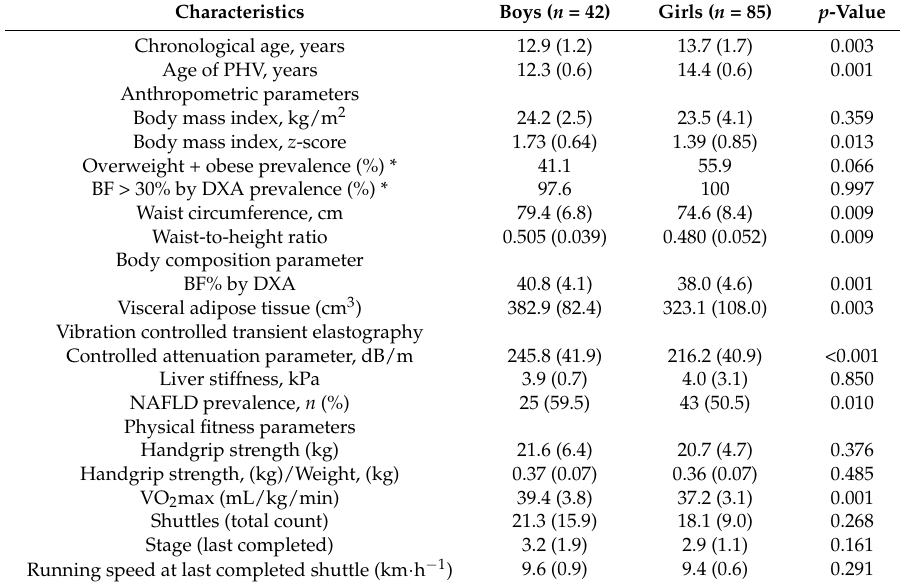
Table 1. Descriptive characteristics of participants by sex.